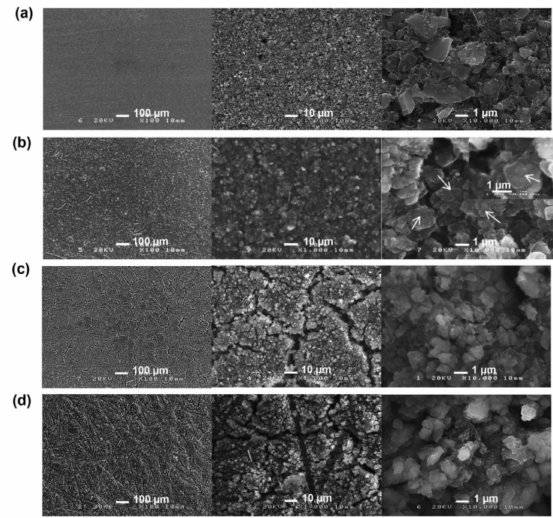
Figure 2. Electrode change [27]: ( a ) Not cycled; ( b ) The first discharge; ( c ) The first charge; ( d ) 10